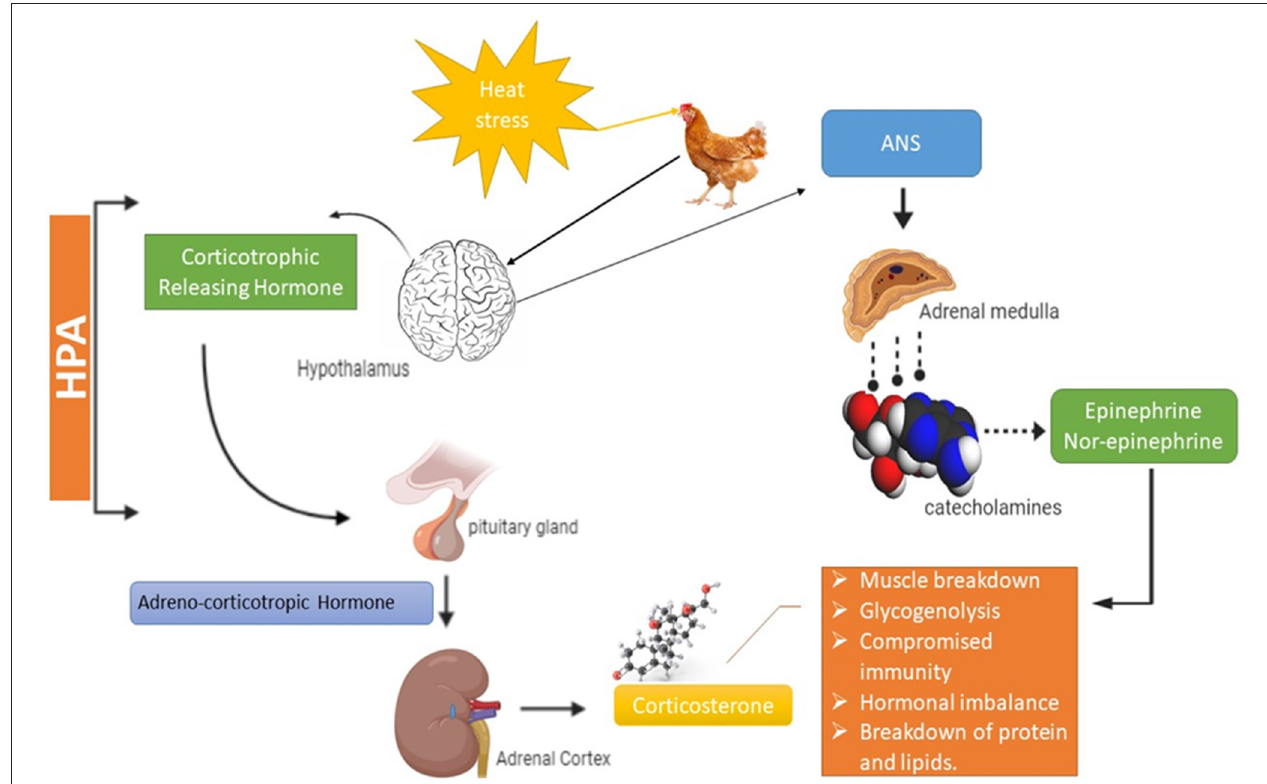
FIGURE 2 | Mechanism of heat stress in broiler. HPA, Hypothalamic pituitary adrenal axis; ANS, Autonomic nervous